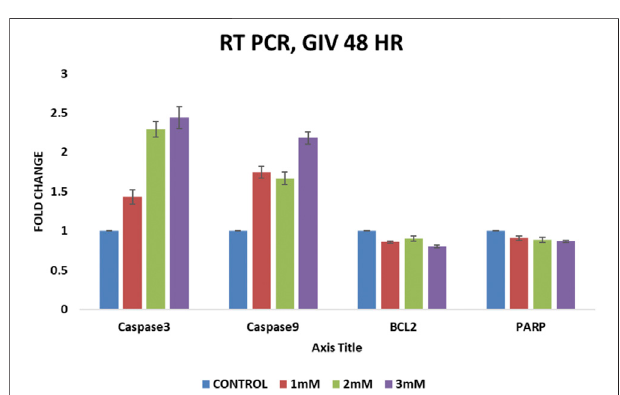
FIGURE 6 | QPCR analysis of apoptosis-regulating genes Bcl2, Caspase-3, Caspase-9, and PARP. HCT116 cells treated with different concentrations of GIV show an increase in expression of proapoptotic caspase-3 and -9 and a decrease in expression of antiapoptotic Bcl-2 and PARP